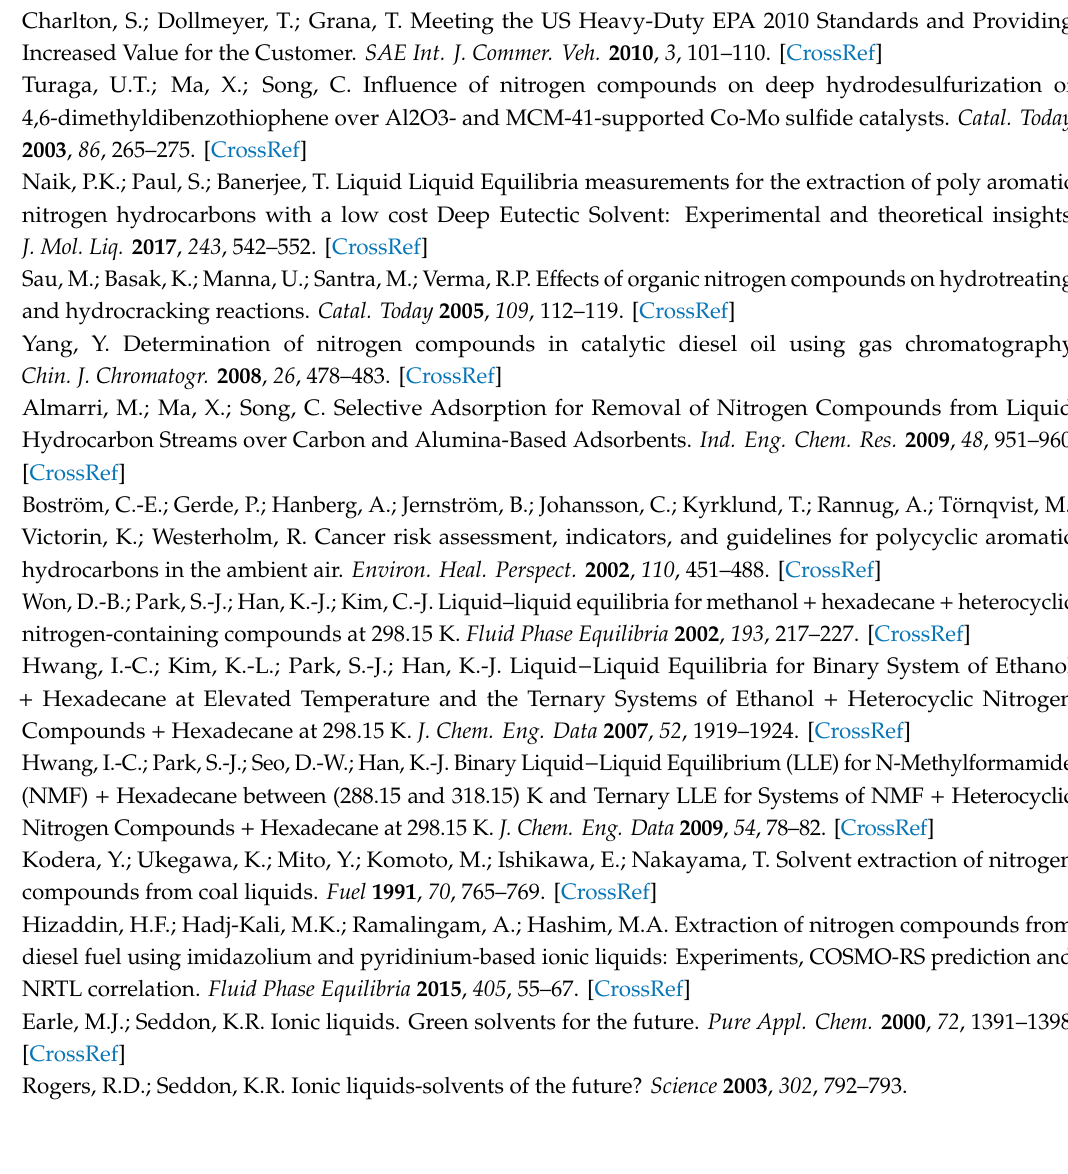
Supplementary Materials: Table S1: Density and viscosity of DES TBPBr:PTSA (1:1), Table S2: Fitting parameters for linear fit of the density as function of temperature, Table S3: Fitting parameters for viscosity as function of the temperature according to Arrhenius equation, Table S4: Prediction values of LLE of quinoline from n-heptane by COSMO-RS, Table S5: Prediction values of LLE of quinoline from pentadecane by COSMO-RS, Table S6: Prediction values of LLE in extraction of quinoline from heptane by NRTL, Table S7: Prediction values of LLE in extraction of quinoline from pentadecane by NRTL, Table S8: Di ff erent signal detected for 1H-NMR for TBPBr:PTSA (1:1) DES, Table S9: Di ff erent signal in ra ffi nate phase of pentadecane system detected by 1H-NMR, Figure S1: Calibration curve of heptane and pentadecane for GC, Figure S1: Glass transition temperature of TBPBr / PTSA (1:1). The solid line illustrates the heat flow of DES, Figure S2: FTIR analysis for DES TBPBr:PTSA (1:1) where blue indicates the tetrabutylphosphonium salt, green indicates p -toluenesulfonic acid and red indicates the